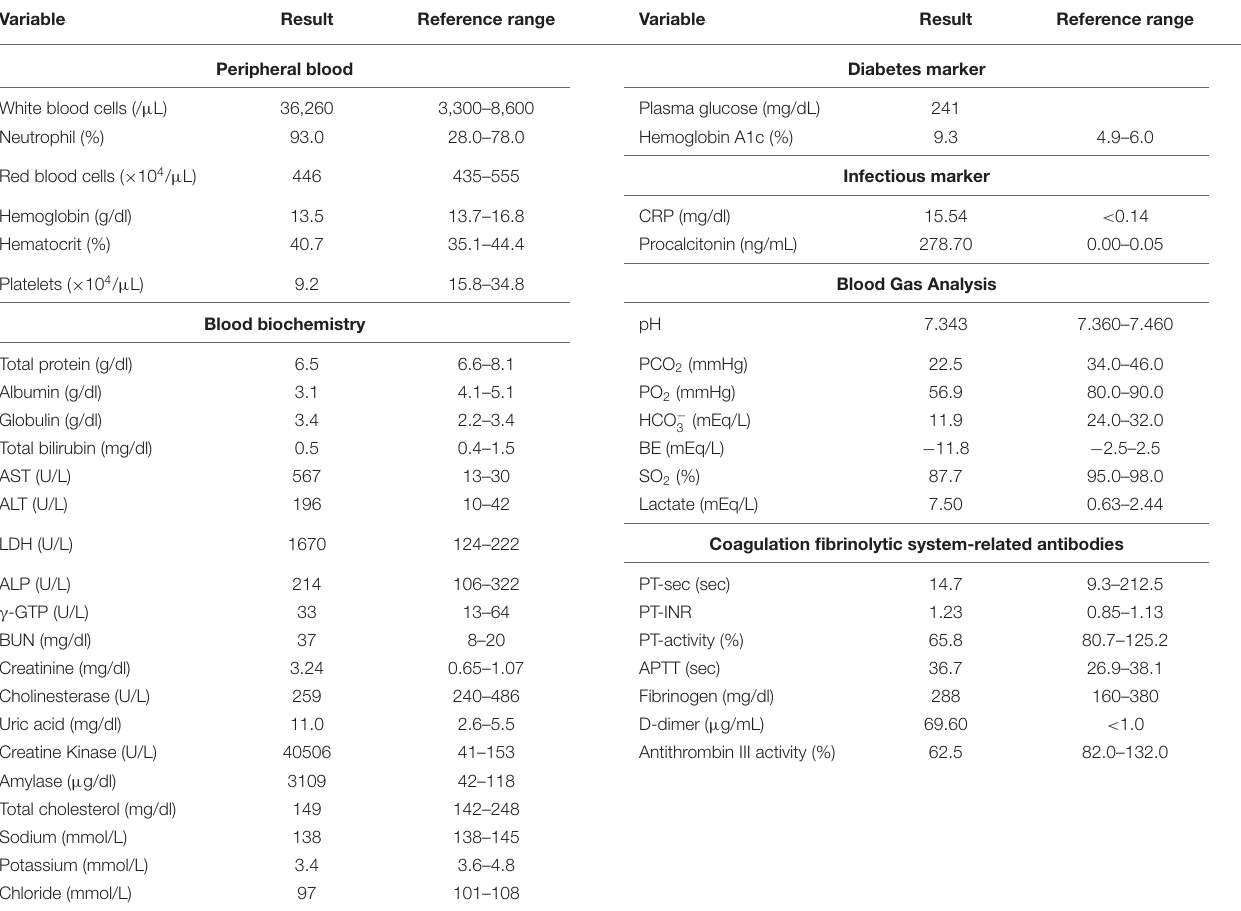
TABLE 1 | Laboratory data in an emergency room in this